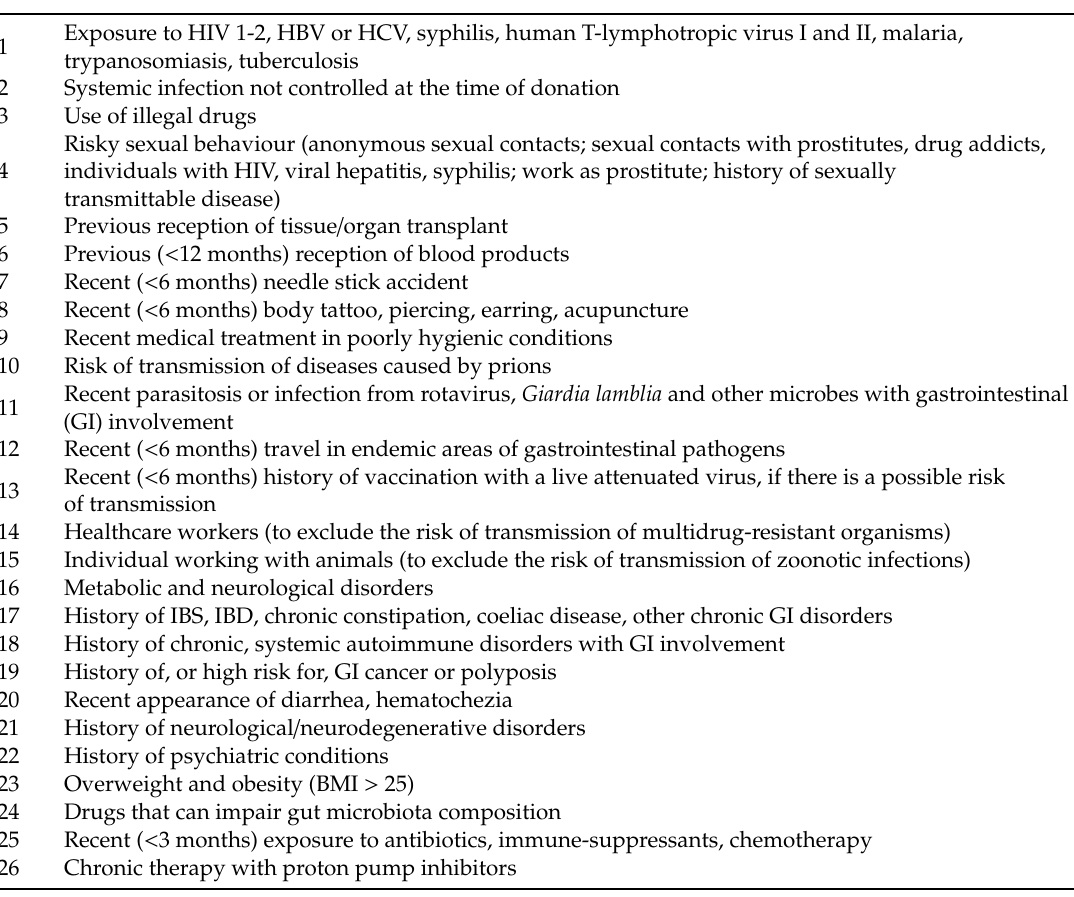
Table 1. List of key issues of the European Commission used to select potential donors at the preliminary